Question: Sum up the contents of this chart in one sentence.
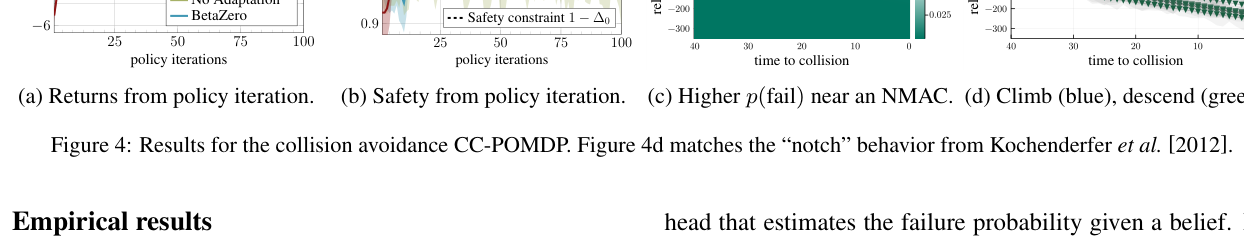
Answer: compares ConstrainedZero against BetaZero, where BetaZero uses different values of the penalty λ. The penal- ties were swept between −10 and −1000 with −100 being the standard for the LightDark POMDP (proportional to the goal reward of 100). A target safety level of ∆0 = 0.01 was chosen for ConstrainedZero. ConstrainedZero exceeds the BetaZero Pareto curve and achieves the target level of safety with a failure probability of 0.01 ± 0.01 computed over 100 episodes. Notably, ConstrainedZero also has less variance in the failure probability and the returns. BetaZero still achieves good performance but at the cost of sweeping the penalty val- ues without explicitly defining a safety threshold to satisfy. Shown in table 1, an ablation study is conducted for Con- strainedZero. Most notably, the adaptation procedure is cru- cial to enable the algorithm to properly balance safety and utility during planning (also shown in fig. 4a–4b). When comparing ∆-MCTS without network approximator